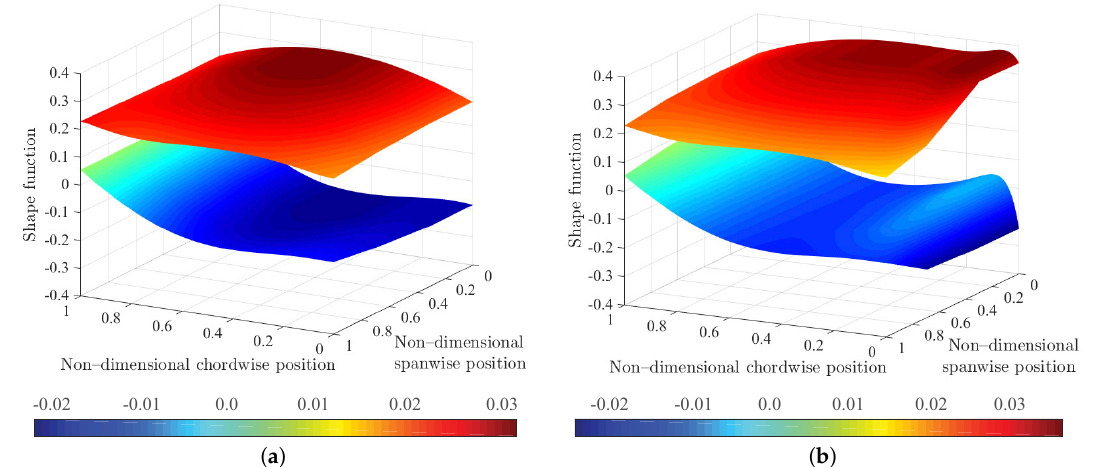
Figure 8. Non-dimensional shape functions of undeformed ( a ) and morphing ( b ) wing geometries: colors indicate the values of the function S ( ψ , η ) in the non-dimensional square domain.